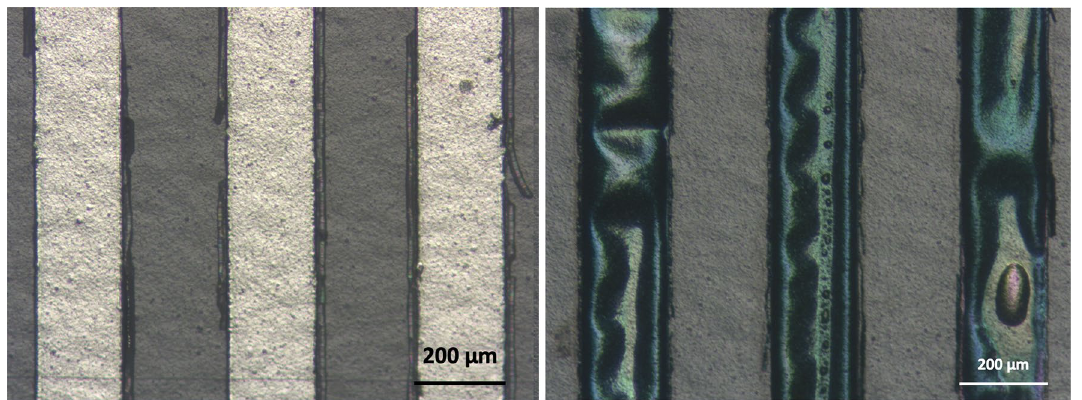
Figure 5. Optical micrographs of serpentine region of thin film microheater before (left) and after (right) heat treatment at 350